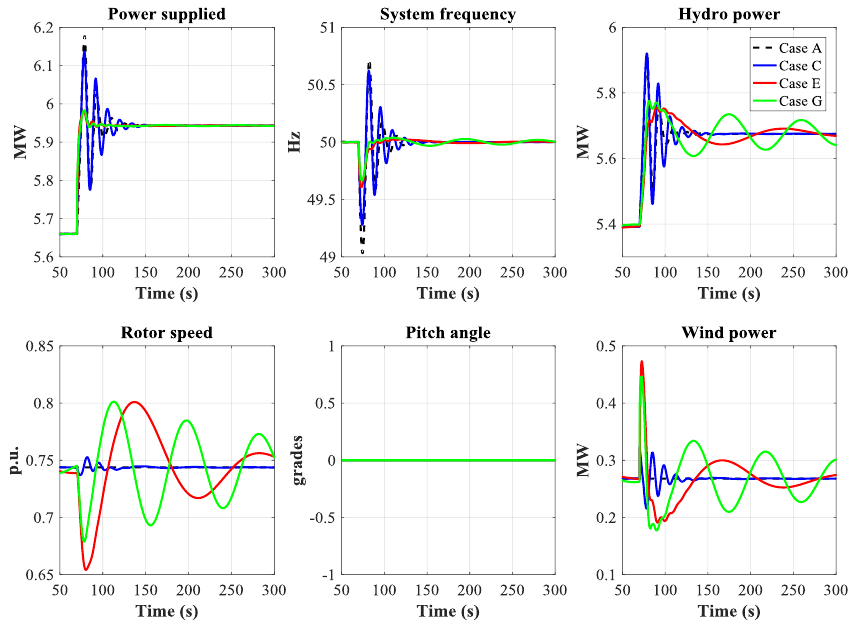
Figure 11. Comparison of the dynamic response of the system between the base case and the case in which the VSWT contributes to frequency regulation by combining the inertial and proportional control, and by considering a sudden power demand variation and a constant wind speed of w s = 6 m/s.